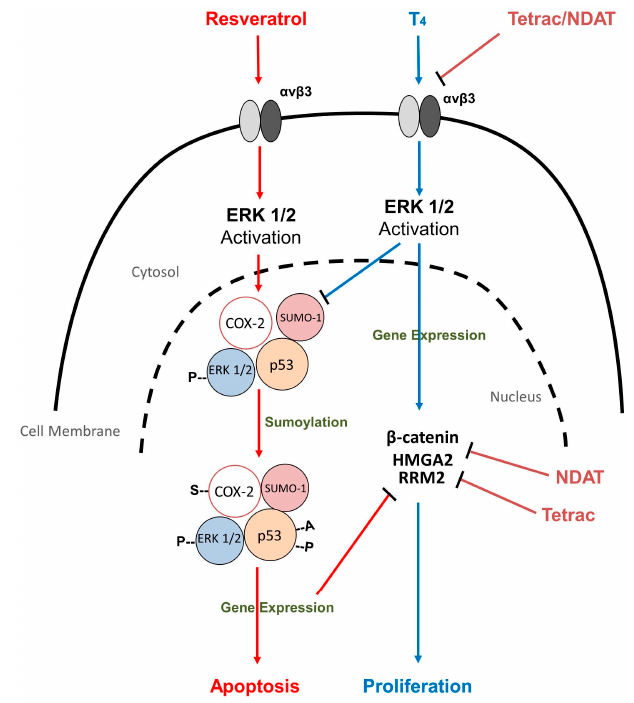
Figure 1. Thyroid hormone-induced interference with resveratrol-induced antiproliferation is blocked by tetrac and its nanoparticulate analog. Signal transduction pathways are involved in resveratrol-induced antiproliferation and thyroid hormone-mediated proliferation in cancer cells. Thyroid hormones, as T 4 , in physiological concentrations, stimulate cancer cell proliferation via the hormone receptor site on integrin α v β 3, on the cell surface. Activated ERK1/2 (pERK1/2) is required for hormone-dependent cell proliferation, as shown by the ERK1/2 cascade inhibition by the selective inhibitor, PD98059. A distinct receptor for the stilbene is also present on integrin α v β 3, through which resveratrol activates ERK1/2 and induces nuclear cyclooxygenase (COX-2) accumulation. Phosphorylated ERK1/2, induced by resveratrol, also translocates into the cell nucleus and complexes with inducible COX-2 in resveratrol-treated cancer cells. This is an essential upstream step in the induction by resveratrol of p53 phosphorylation at Ser-15, and consequent p53-dependent antiproliferation. Blocking resveratrol-induced nuclear accumulation of COX-2 inhibits p53 phosphorylation and antiproliferation. T 4 inhibits the formation of the intranuclear pERK1/2-COX-2–p53 complex and consequent p53-dependent antiproliferation. The mechanism by which T 4 inhibits the generation of pERK1/2–COX-2–p53 nuclear complexes in resveratrol-exposed cells is not yet known. Although the activation of ERK1/2 induced by hormones and resveratrol is additive, the competition for pools of ERK1/2 between thyroid hormones and resveratrol appears to divert kinases to the cell proliferation pathway, and may play an important role in the inhibition by T 4 of resveratrol's pro-apoptotic action. Tetrac inhibits the expression of β -catenin and HMGA2, and NDAT inhibits the expression of RRM2, which is caused by resveratrol. In addition, both tetrac and NDAT activate the expression of Chibby, which binds to β -catenin and blocks its transcriptional activities. Thus, tetrac or NDAT may restore pro-apoptotic activity of resveratrol that has been lost due to the actions of endogenous thyroid hormones. Abbreviations: COX-2, cyclooxygenase-2; HMGA2, high mobility group AT-hook 2; tetrac/NDAT, tetraiodothyroacetic acid/nano–diamino–tetrac; RRM2, ribonucleoside diphosphate reductase subunit M2; Chibby, nuclear protein that directly binds to β -catenin and antagonizes its transcriptional activity; SUMO-2, small ubiquitin-related